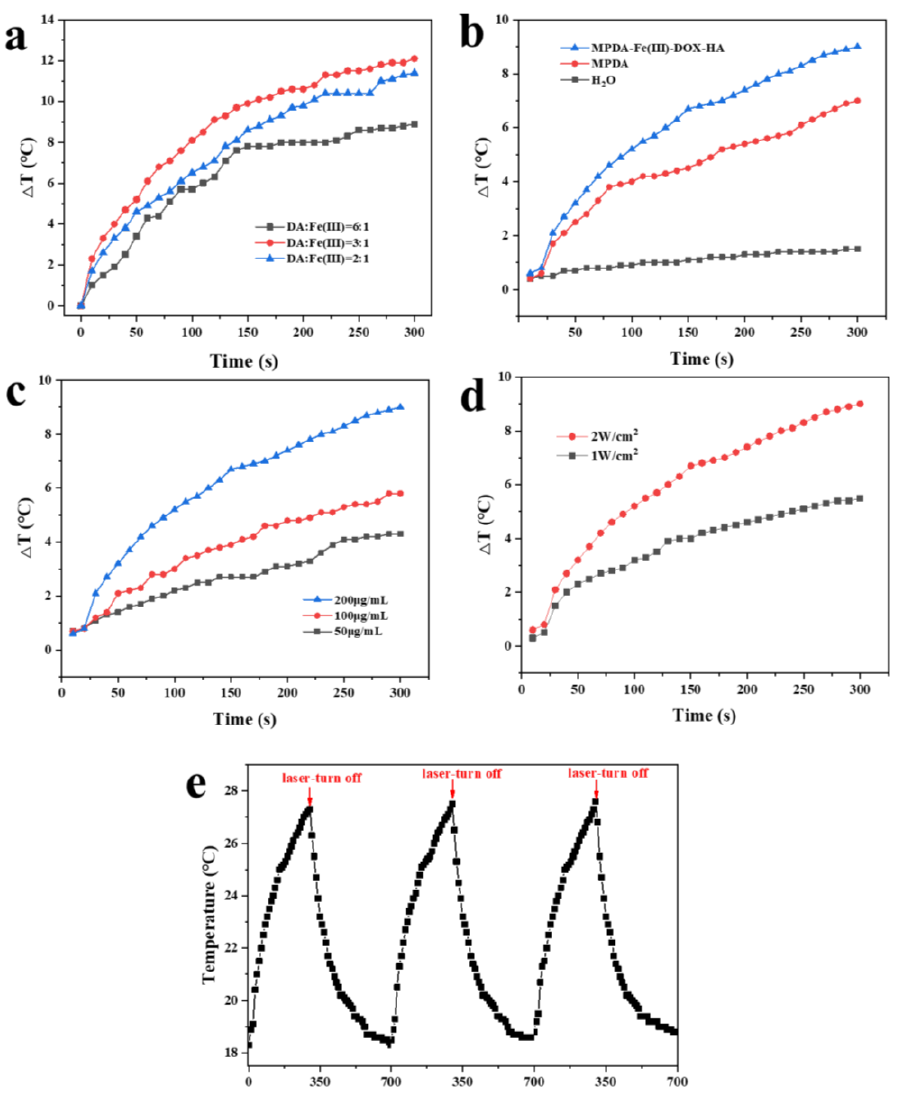
Figure 7. After 5 min of 2 W/cm 2 NIR laser irradiation, the temperature difference curve of different DA:Fe molar ratio ( a ), materials ( b ), and MPDA-Fe(III)-DOX-HA concentration ( c ). Temperature difference curve for a 1 mg/mL MPDA-Fe(III)-DOX-HA solution at various laser powers ( d ). The temperature change per 10 s of 5 min irradiation by a 2 W/cm 2 NIR laser after three cycles of cooling to room temperature ( e ).